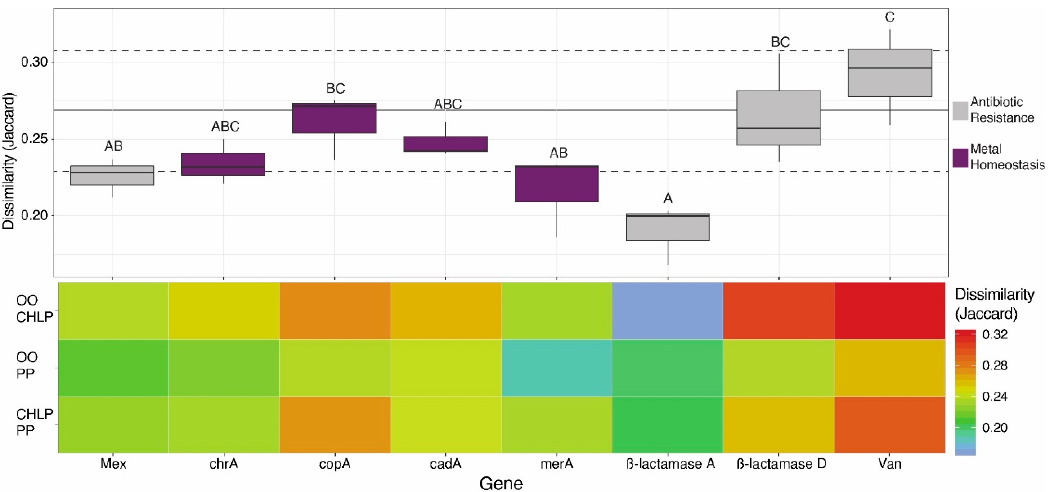
Figure 3. Diversity of antibiotic resistance and metal homeostasis genes between the sediments. Along the top are the box plot representing the three scores with letters indicating significant levels of difference between genes using the Tukey HSD test. The solid, horizontal line represents the average dissimilarity across the whole GeoChip bounded by the 95% confidence interval (dashed lines). The heatmap along the bottom illustrates the dissimilarity score calculated for each of the three sediment pairs (OO-CHLP, OO-PP, and PP-CHLP). Note: few qnr genes were detected by the GeoChip (only four across all sites); therefore, these genes were not included in the diversity analysis shown below (see Figure S1 in Supplementary Materials for additional details).